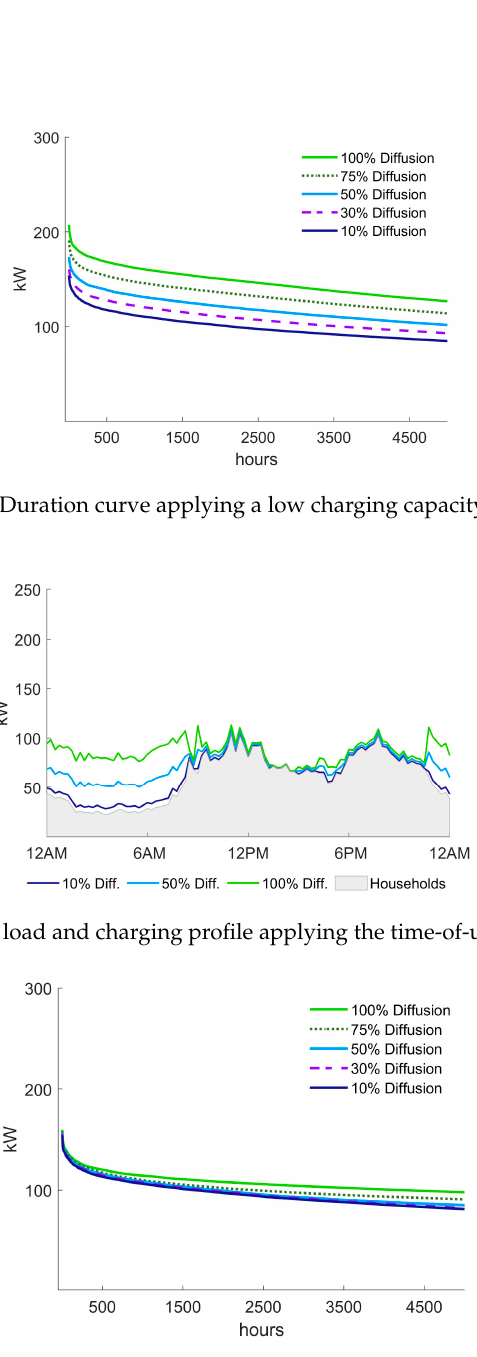
Figure 10. Duration curve applying the ToU approach.